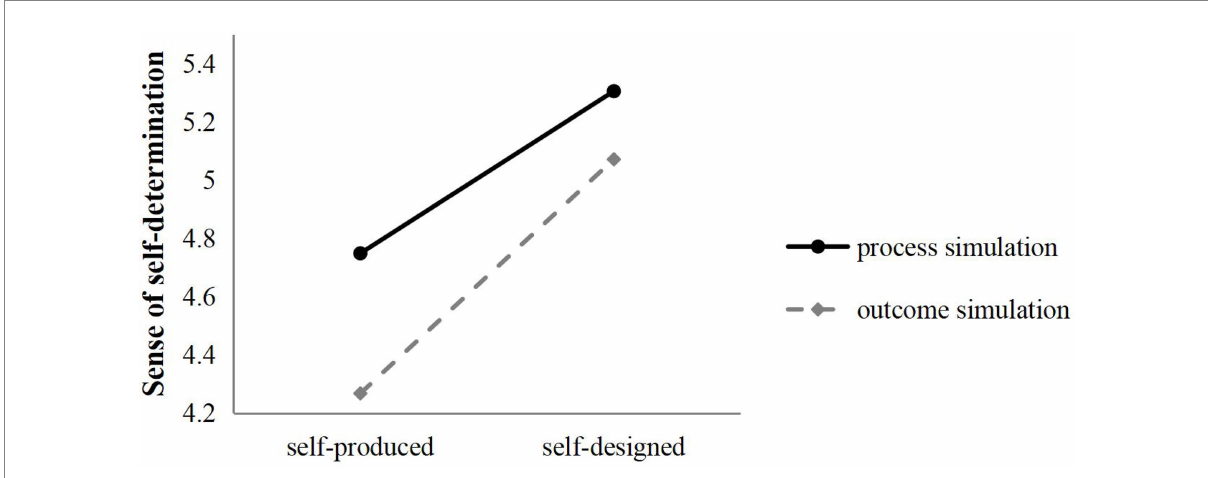
FIGURE 2 Moderating effect of mental simulation (sense of